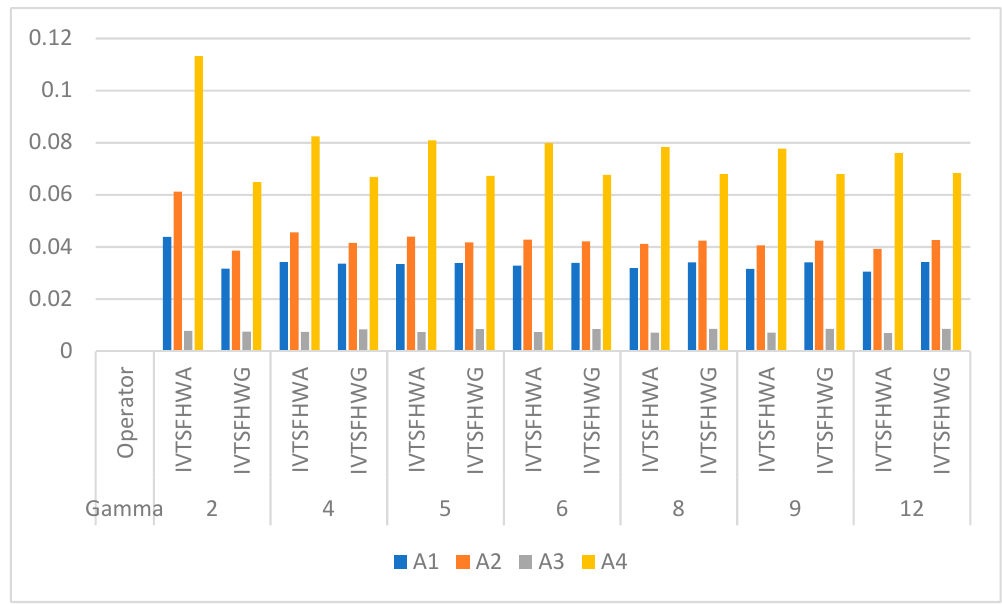
Figure 2 . Graphical view of Table 4. Figure 2. Graphical view of Table